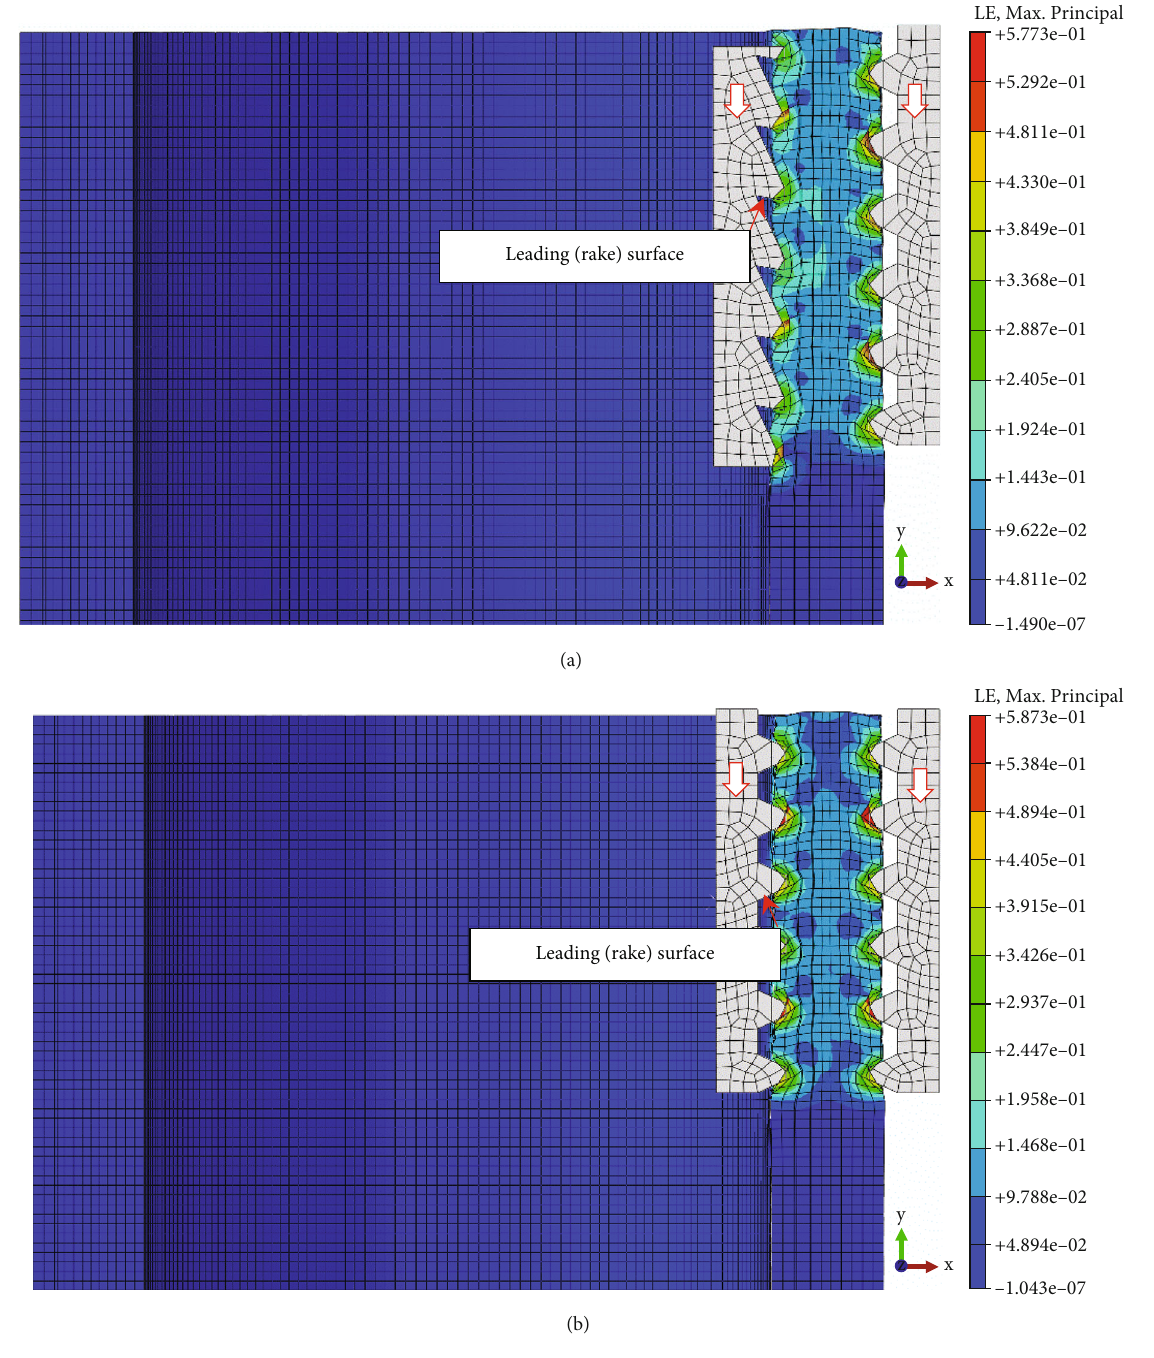
Figure 7: Resulting maximum principal strain in the working process for (a) bionic and (b) traditional crimping